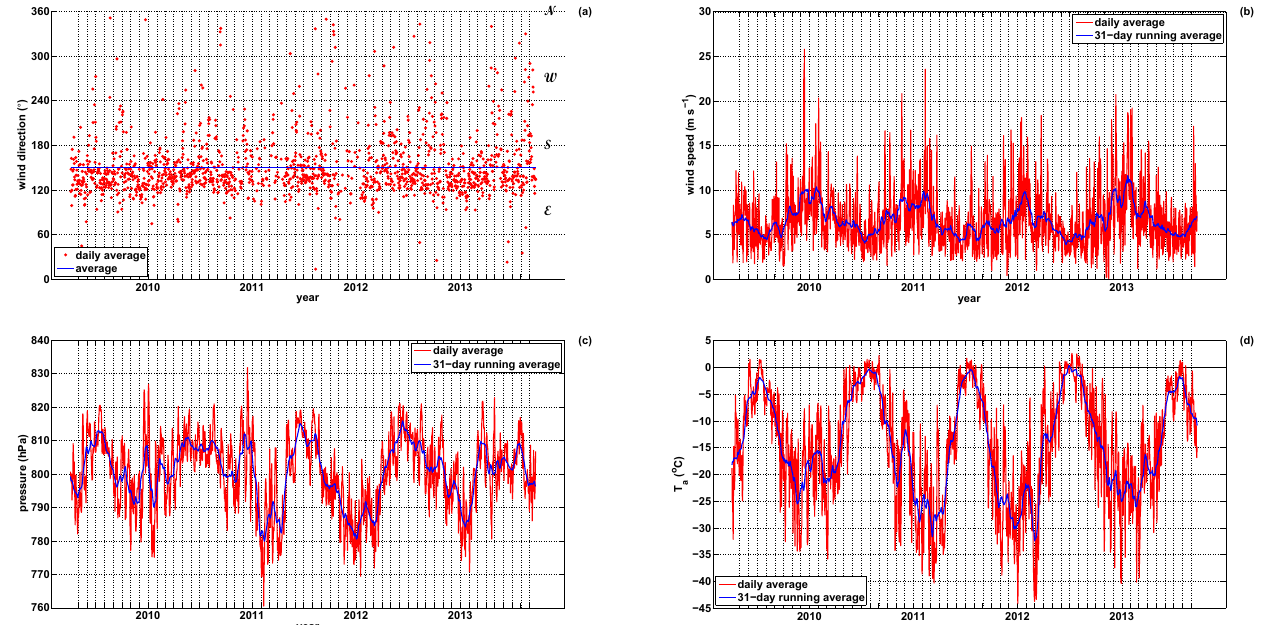
Figure 3. Average values of (a) wind direction, (b) wind speed, (c) air pressure, and (d) air temperature at